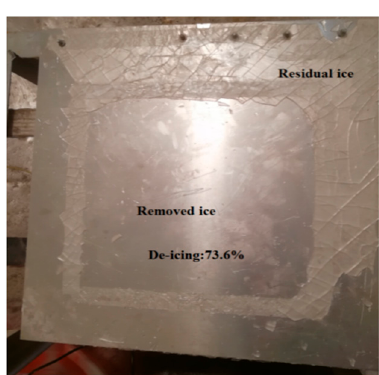
Figure 7. Ice layer shedding process.